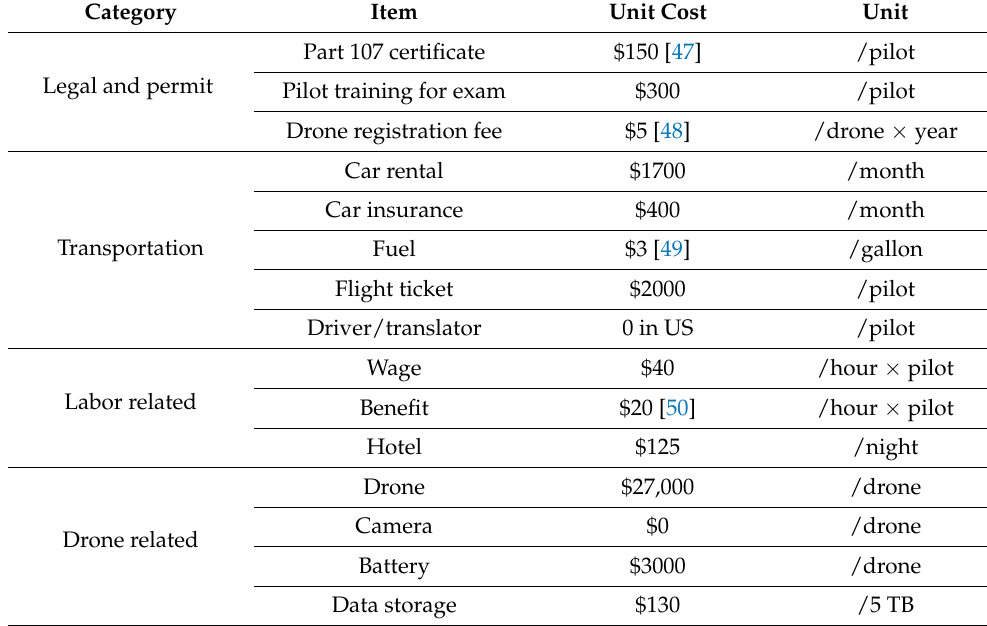
Table 2. Table with detailed breakdown of the cost assumptions in each category for US-based operation. References embedded with hyperlinks. Note that nearly all of the unit prices in this chart vary greatly with the operational location of interest, and therefore anyone referencing this cost estimate framework should adjust according to local conditions and prices. A detailed calculation and explanation of our cost assumptions are given in the appendix and can be found at our code repository. Category Item Unit Cost